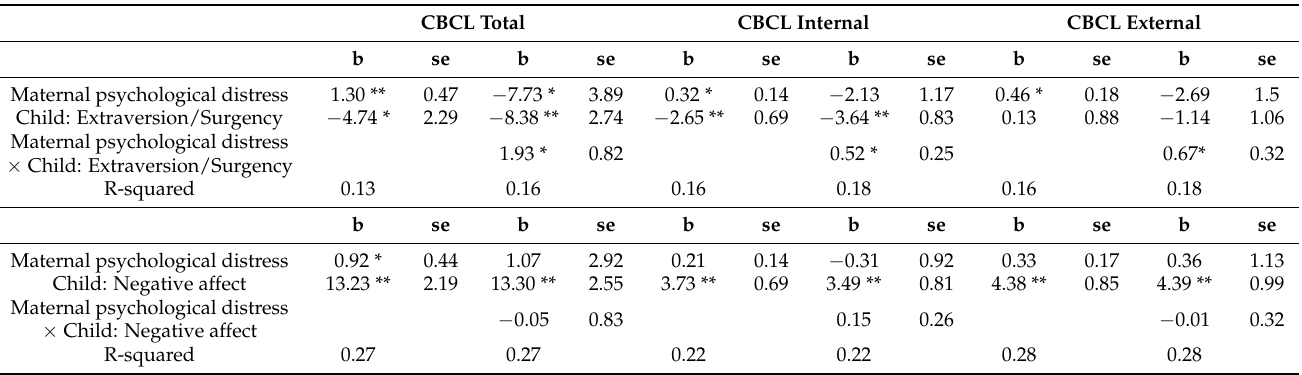
Table 6. The association between maternal psychological distress and child temperamental character- istics with child problem behavior.